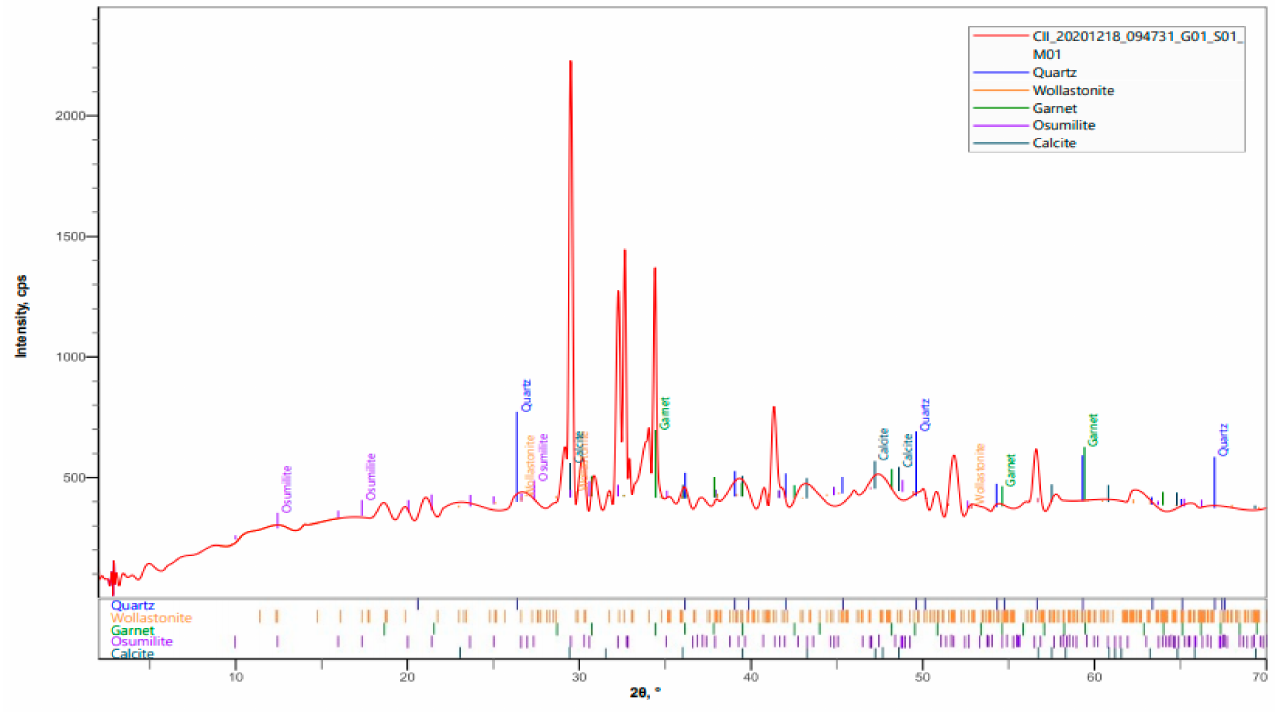
Figure 2. The XRD patterns of CEM